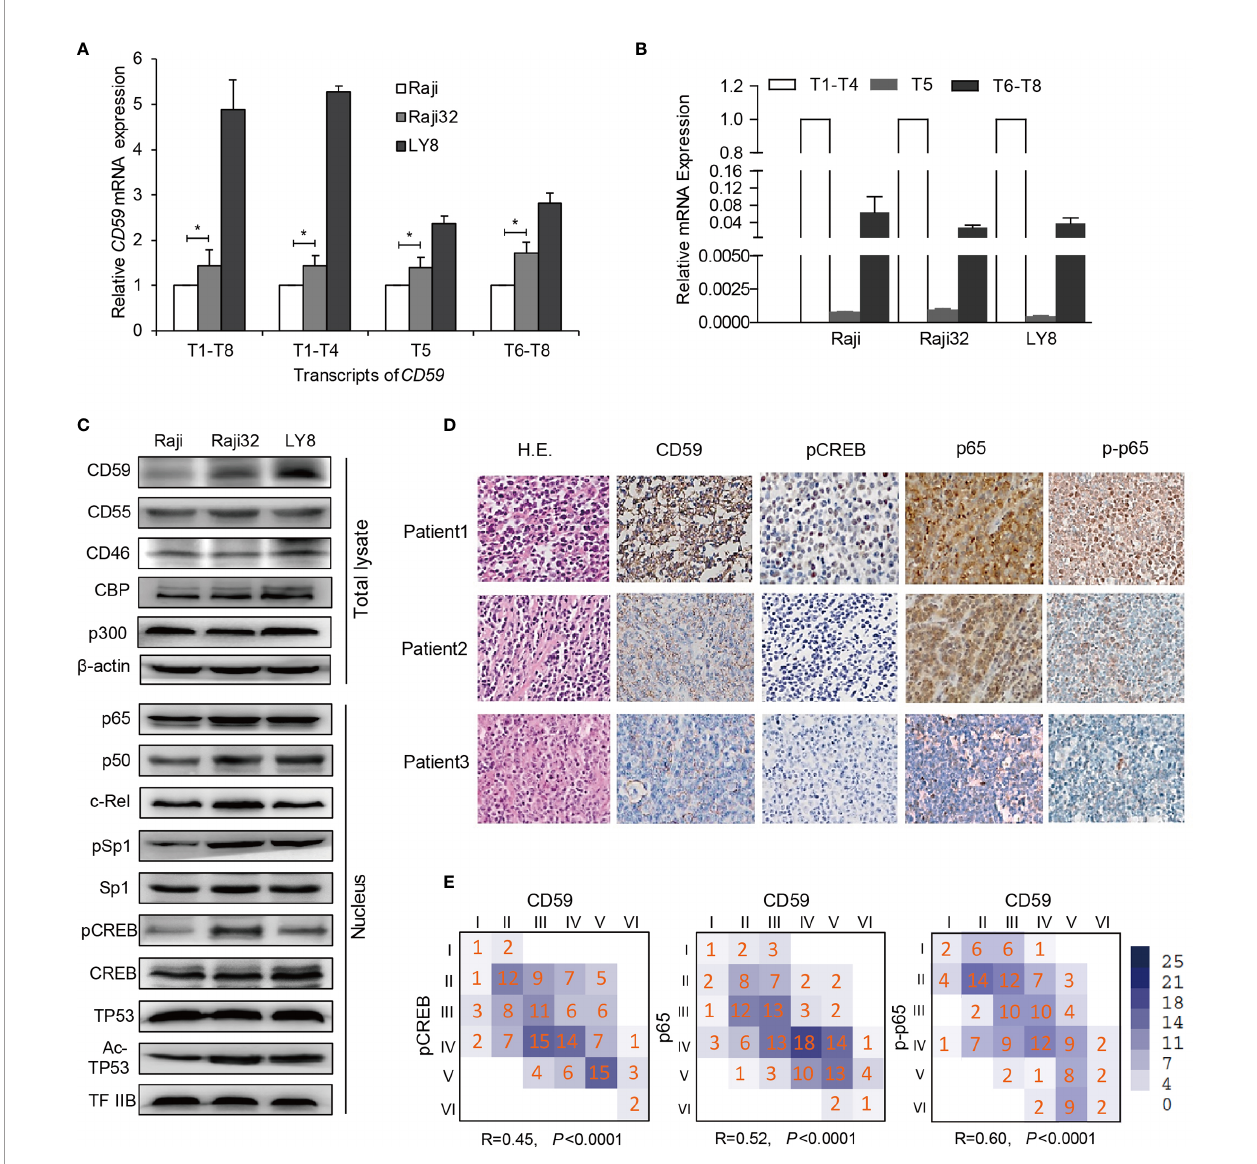
FIGURE 2 | The inducible CD59 transcription is regulated by CREB and NF- k B. (A) A comparison of the abundance of CD59 transcripts determined by qRT-PCR as the fold changes relative to Raji cells. Values are reported as mean ± SD of triplicate samples. * P < 0.05 vs. Raji, as analyzed by unpaired two-tailed Student ’ s t test. T1-T8: total transcripts; T1-T4: group 1 transcripts regulated by Sp1 or by NF- k B and CREB; T5: group 2 transcripts regulated by TP53; and T6-T8: group 3 transcripts regulated by CREB, as reported previously (23). (B) A comparison of the abundance of the three CD59 transcriptional groups detected by qRT-PCR and normalized to T1-T4, n = 3. Values are reported as mean ± SD. (C) An immunoblotting assay was used to compare the expression levels of CD59 in total lysates and the nuclei of sensitive and resistant cells. b -actin and TFIIB were used as controls for the total lysate and nuclear fraction, respectively. (D) The IHC results of three representative DLBCL patients demonstrate that CD59 staining correlates well with the levels of NF- k B (p65), phosphorylated p65 (p-p65) and phosphorylated CREB. (E) Statistical correlation of CD59 expression with the activity or expression of its regulators. The Arabic numbers presented in the small squares represent case amounts, and the Roman numbers represent grade scores for each protein. The R and P values were calculated using SPSS software, n =